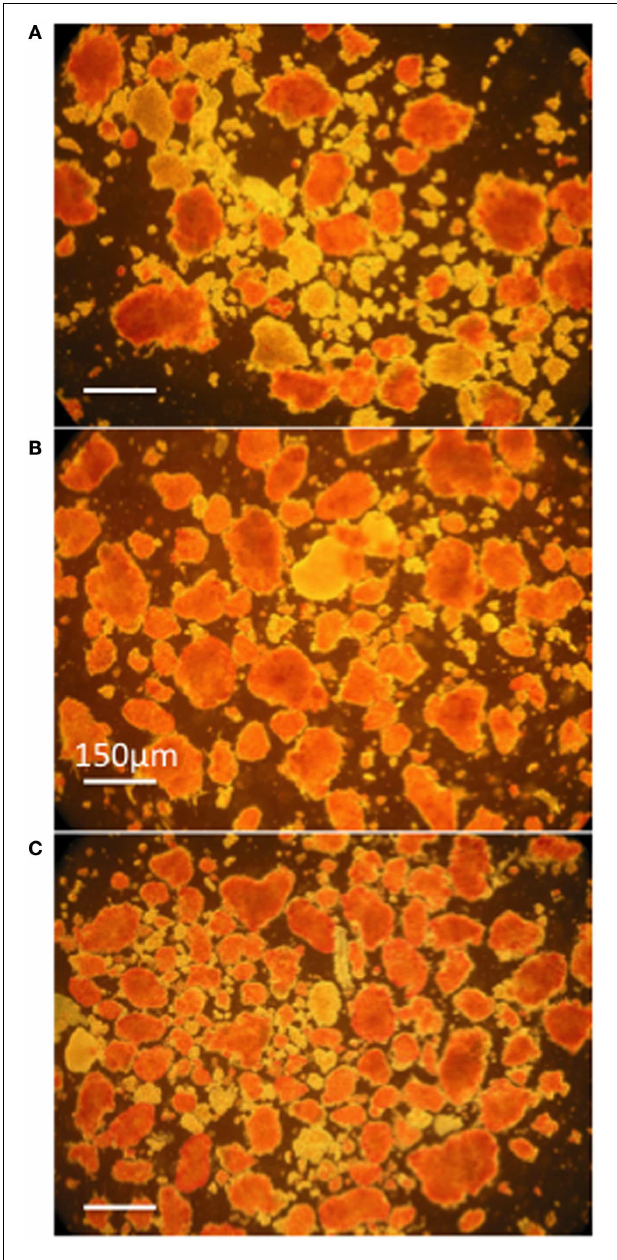
FIGURE 4 | Photomicrographs of dithizone stained islet preparations derived from donor Lewis rat pancreata infused with HBSS/BSA solution (A) and HBSS/BSA solution containing 100 µ M mesobiliverdin IX α (B) or 100 µ M E. coli produced biliverdin IX α -HCl (C). Viable islets are stained red.The bar designates a length of 150 µ m.